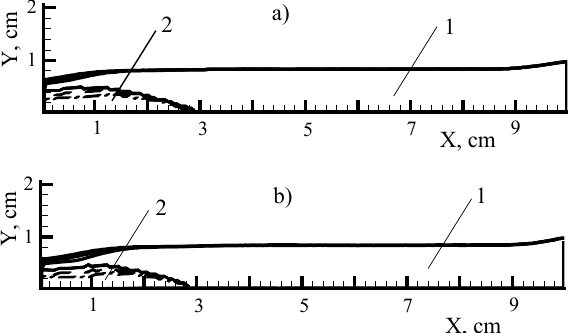
Figure 8: Compacted and destruction regions for various explosive thicknesses under external pressures = 0.05 P Mbar (a) and = 0.075 P Mbar (b). The detonation velocity is = 5 D km/s. The solid, dashed, and dot-and-dash lines refer to the explosive  = 3  cm, and = 5  cm, respectively. The compacted and destruction regions are indicated by 1 and 2. thicknesses = 2 e e e